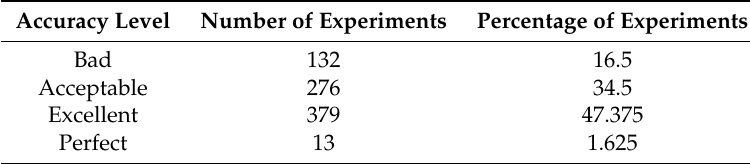
Table 1. A summary of the classifier accuracy performance on the “Steps vs. Random” scenario.